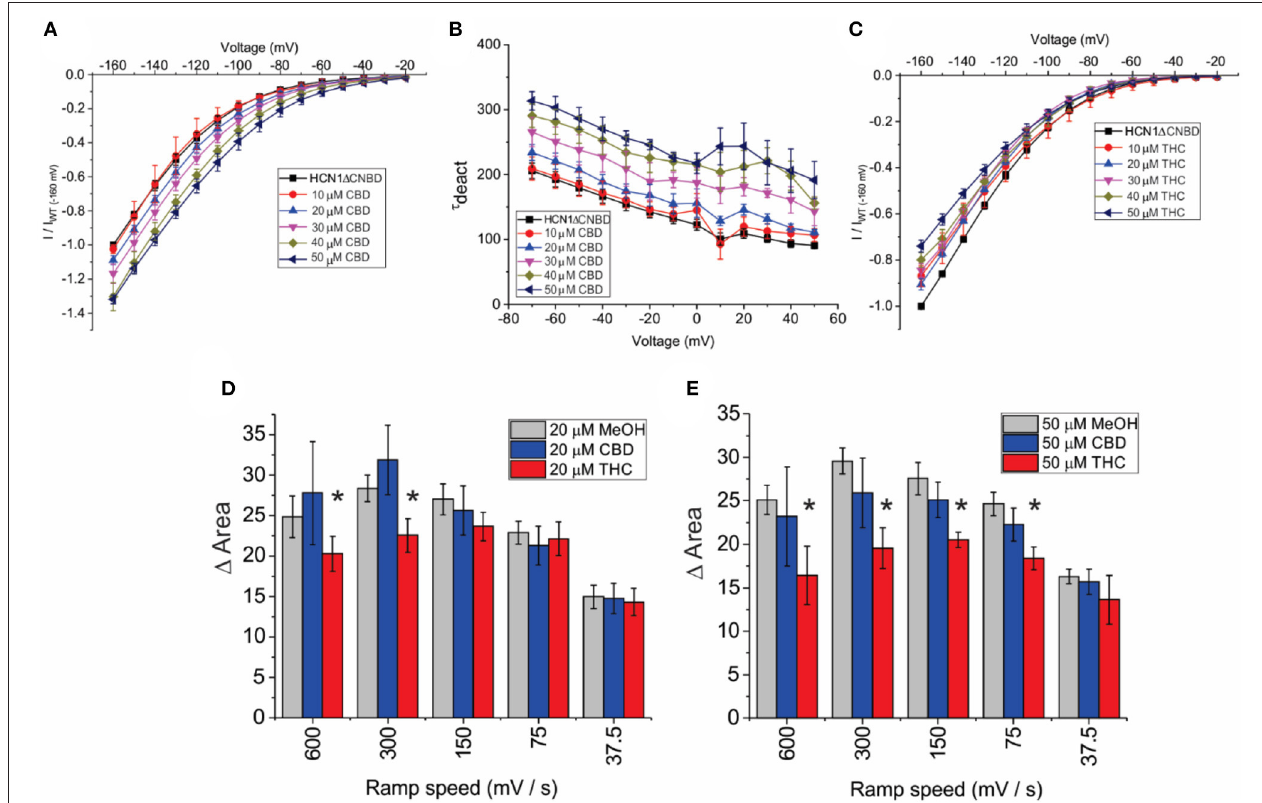
FIGURE 5 | Effects of CBD and THC on HCN1 do not require the CNBD. (A) Current-voltage (I/V) relationship of HCN1 1 CNBD in the presence of increasing concentrations of CBD normalized to maximal current (I WT( − 160mV) ) (4 < n < 13 per condition; P < 0.05 for 20–50 µ M). (B) Deactivation time constant ( τ ) kinetics of HCN1 1 CNBD following treatment with CBD (4 < n < 10 per condition; P < 0.05 for 20–50 µ M). (C) Current-voltage (I/V) relationship of HCN1 1 CNBD in the presence of increasing concentrations of THC normalized to maximal current (I WT( − 160mV) ) (4 < n < 12 per condition; P < 0.05 for 10–50 µ M). (D,E) THC reduces the degree of HCN1 1 CNBD hysteresis at fast ramp speeds, with a greater range of ramp speeds affected as THC concentration increases. CBD did not affect HCN1 1 CNBD hysteresis (3 < n < 10 for each condition; * P <